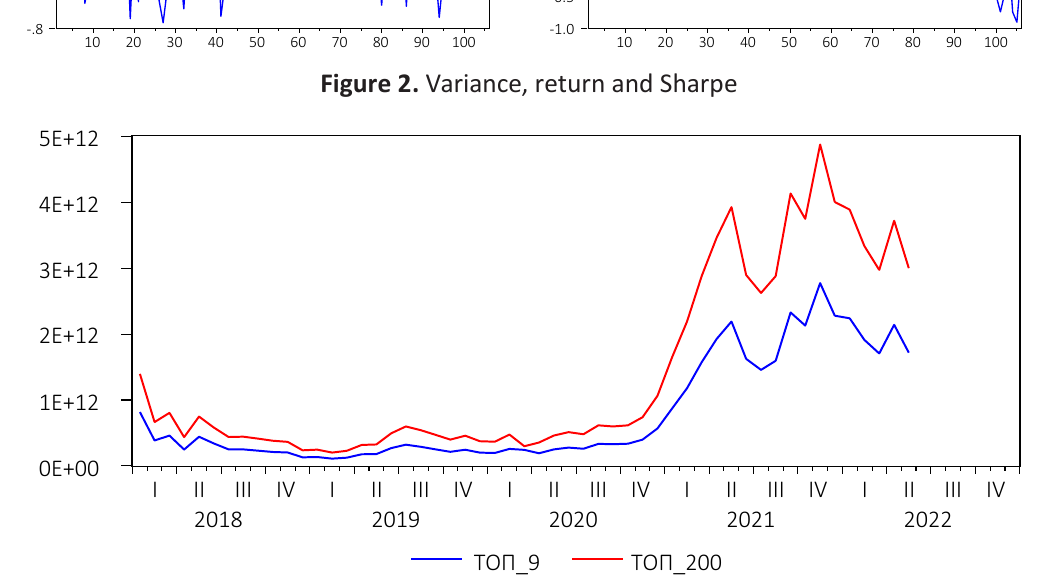
Figure 2. Variance, return and Sharpe